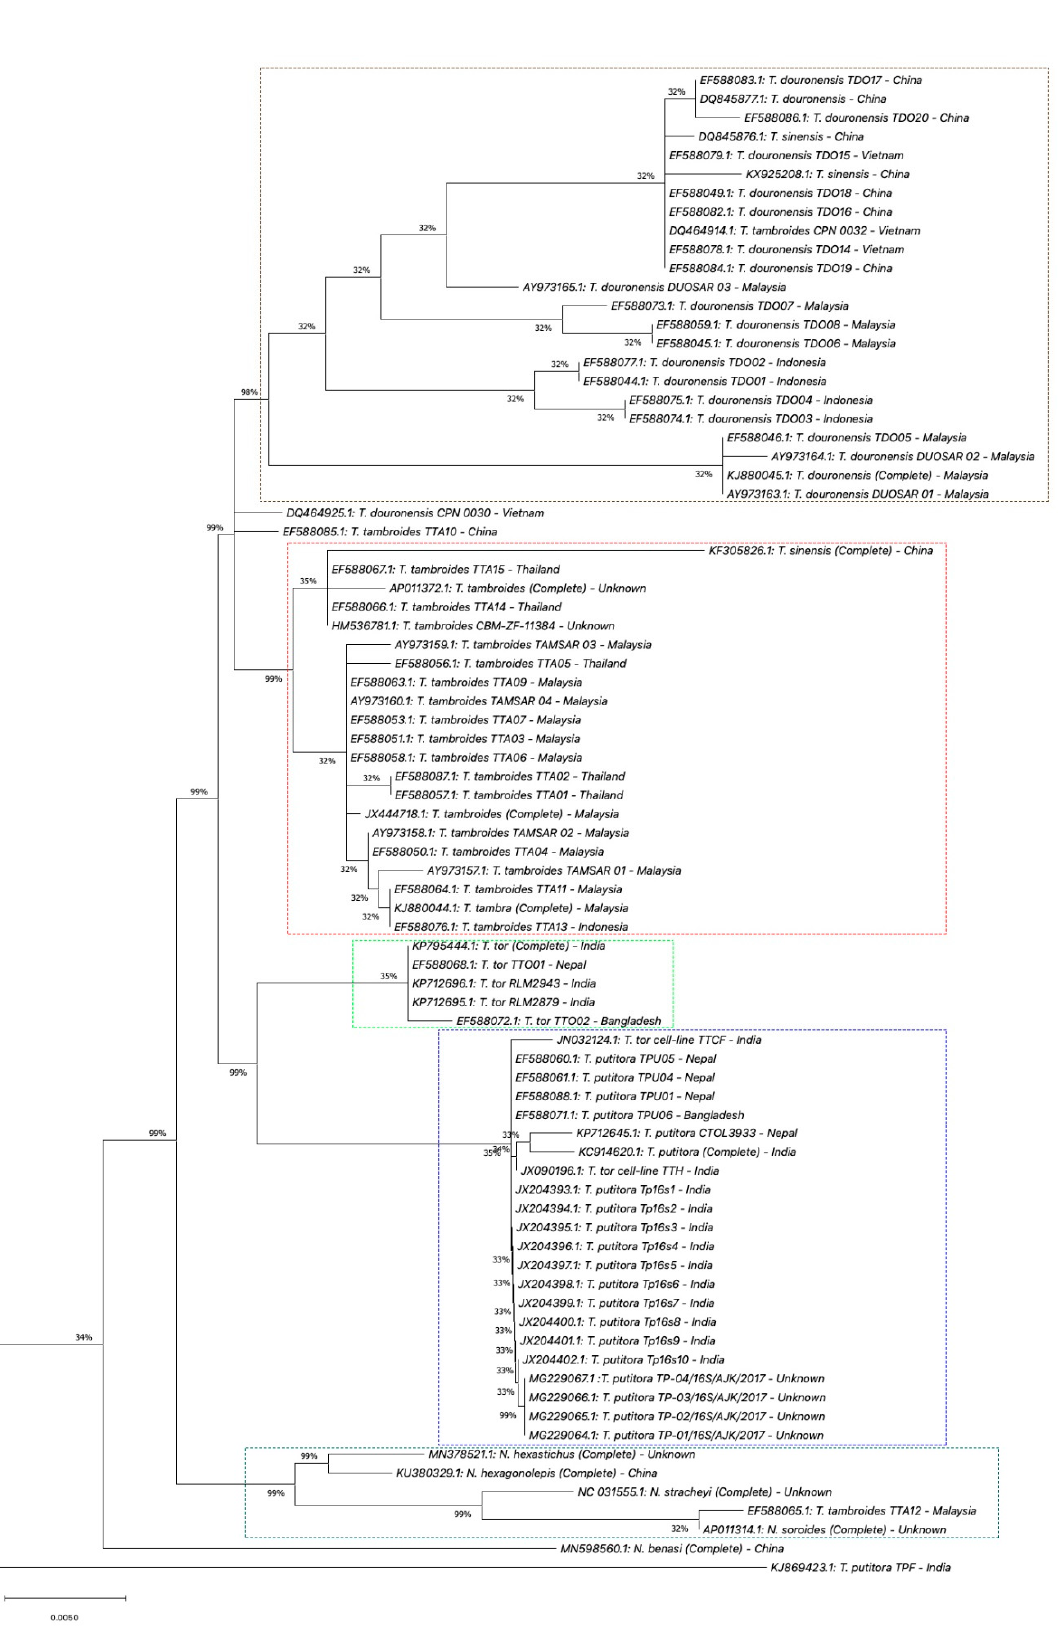
Figure 6. Phylogenetic tree of Tor species using the 16S rRNA gene. The evolutionary history of the listed Tor species was inferred by using the maximum likelihood method and Tamura–Nei model [126]. These analyses were conducted using MEGA X (Version 10.1) [114,115]. Percentages on the branches represent bootstrap values.